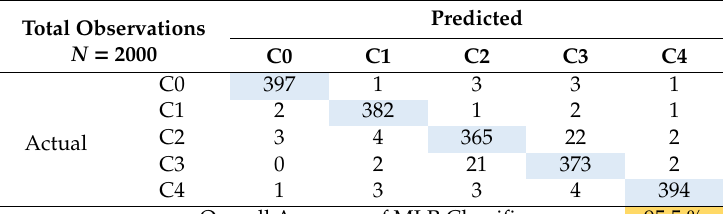
Table 4. Confusion matrix for classification evaluation. MLR—multiclass logistic